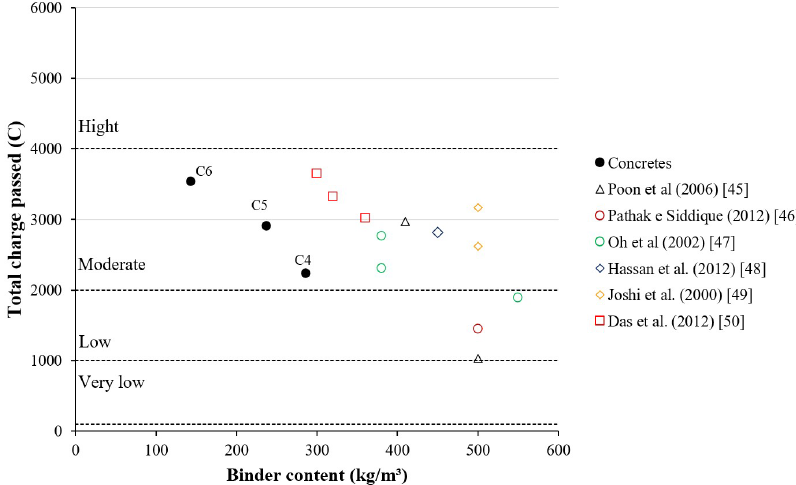
Figure 8. Charge passed versus binder